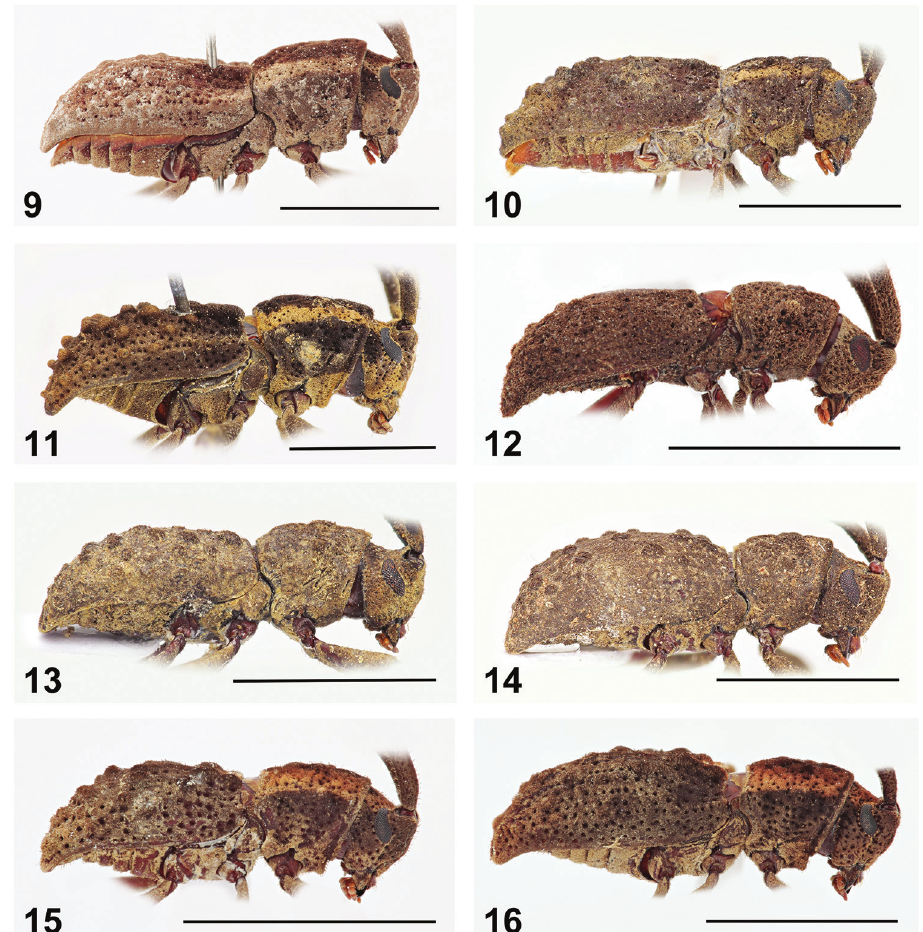
Figures 9–16. Lateral habitus of Anexodus spp.: 9 Anexodus aquilus Pascoe, holotype male 10 Anexodus aquilus Pascoe, female (= holotype of Anexodus kuntzeni Kriesche) 11 Anexodus aquilus Pascoe, large male from Trus Madi 12 Anexodus syptakovae sp. n., holotype male 13 Anexodus sarawakensis Sudre, holotype male 14 Anexodus sarawakensis Sudre, paratype female 15 Anexodus tufi sp. n., holotype male 16 Anexodus tufi sp. n., paratype female. Scale bar 5